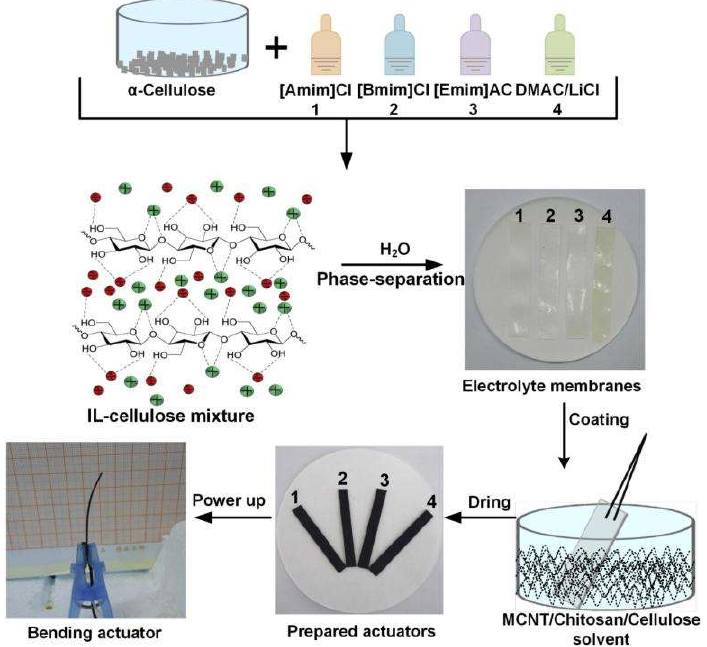
Figure 9. Preparation of biocomposite actuators based on mesoporous renewable cellulose/ionic liq- uids [79]. liquids [79].